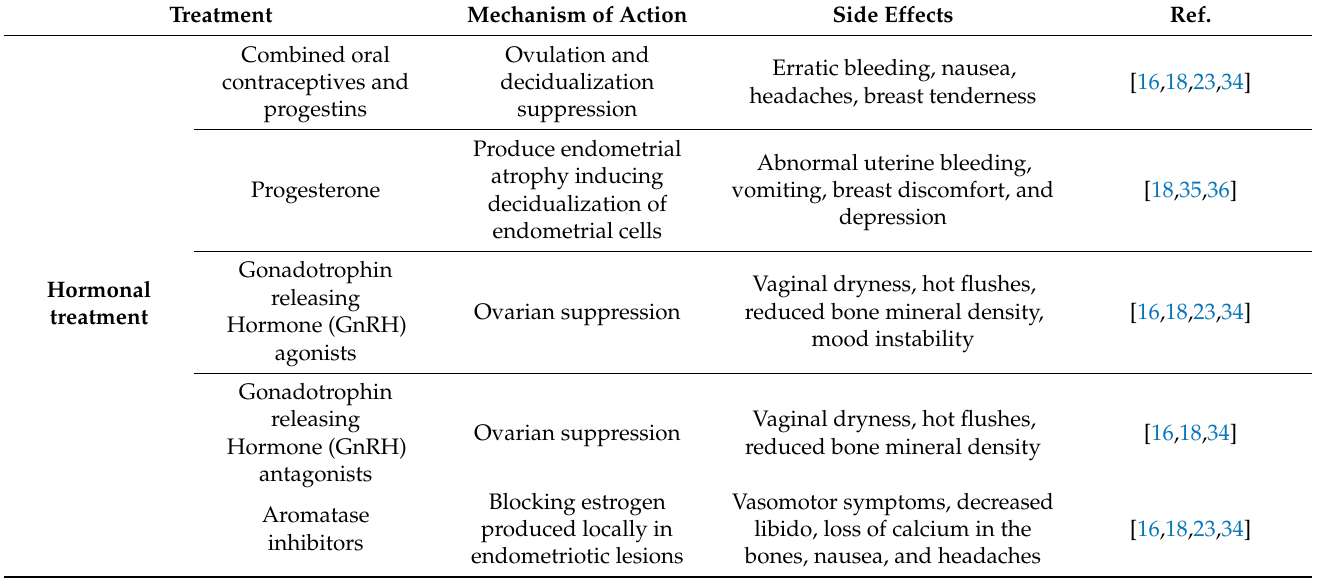
Table 1. Summary of endometriosis treatment. Treatment Mechanism of Action Side Effects